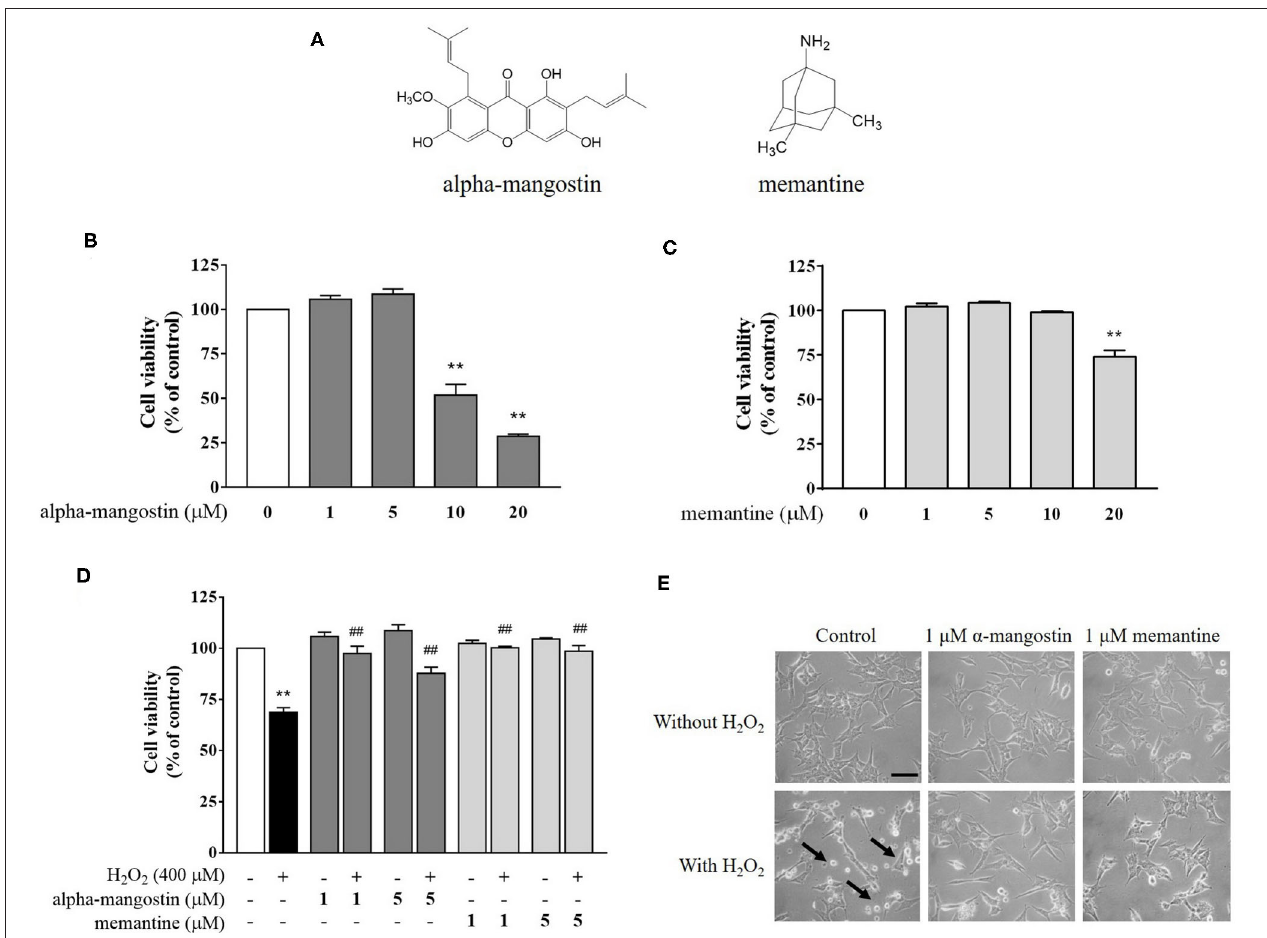
FIGURE 1 | (A) Chemical structures of alpha-mangostin and memantine. (B–D) Protective effects of alpha-mangostin and memantine on H 2 O 2 -induced cell viability in SH-SY5Y cells. The cell viability was assessed with MTT assay. (E) Phase-contrast images of SH-SY5Y cells pretreated with alpha-mangostin and memantine at 40x magnification. The arrows indicate typically round-shaped cells, shrinkage, and no longer adherent. Data are presented as mean ± SEM of four independent experiments. ** P < 0.01 vs. control and ## P < 0.01 vs. H 2 O 2 .